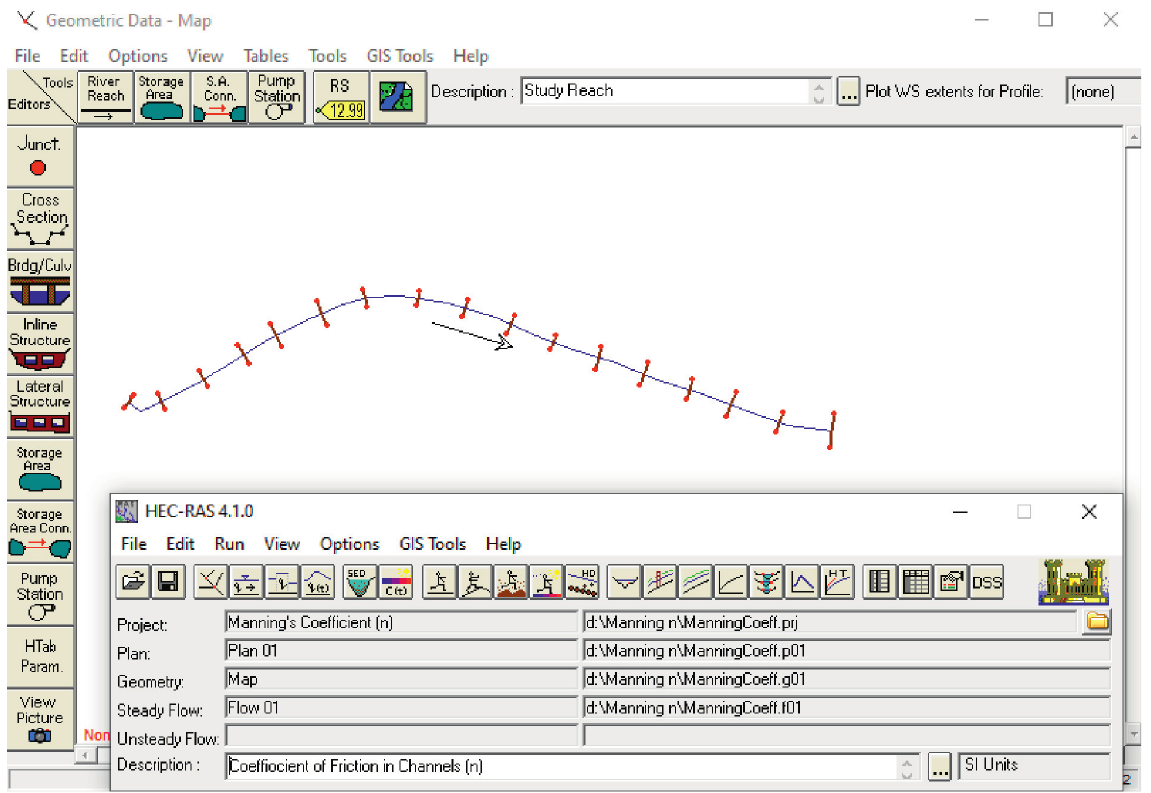
Figure 3: Study reach in the HEC-RAS